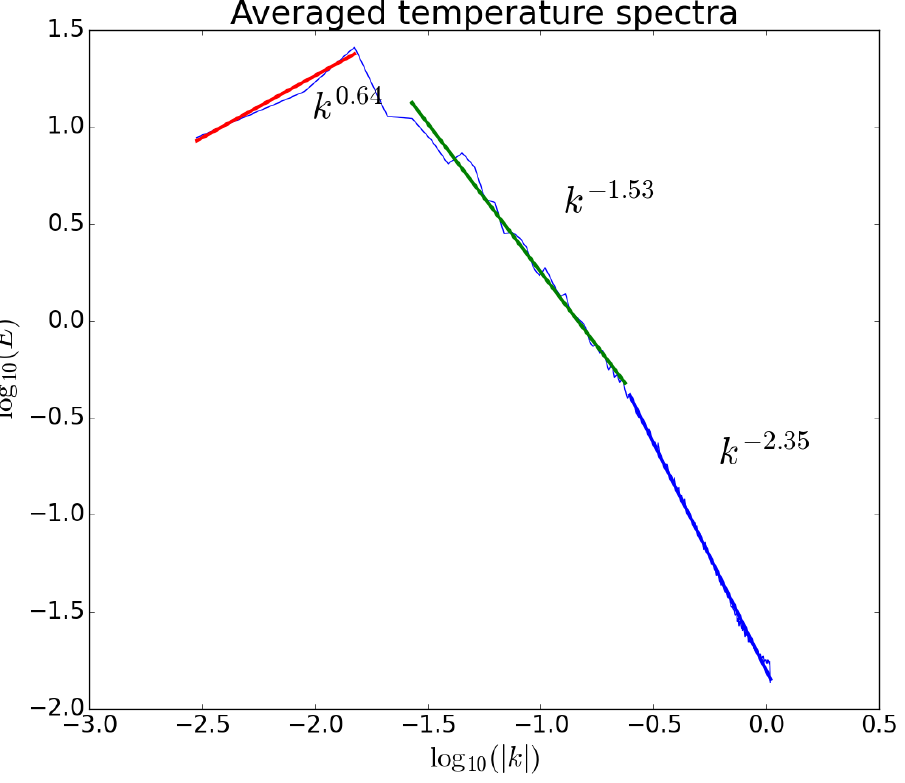
Figure 6. Integrated spectrum of the spatial component of the dynamics of Faraji, averaged over all instants acquisition times, starting from the Fourier spectrum of T ef f